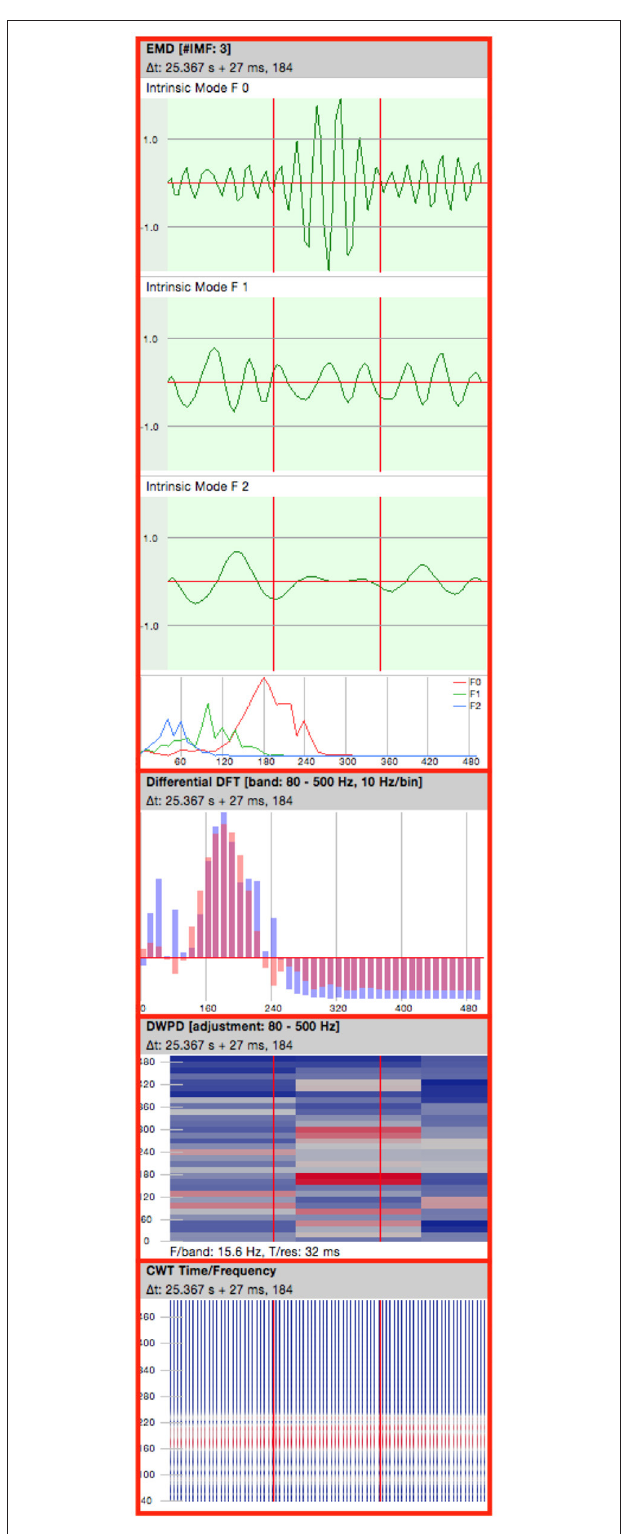
FIGURE 3 | Analysis pane. EMD, Empirical Mode Decomposition (4 consecutive oscillations are shown); DFT, Differential Fourier Transform; DWPD, Discrete Wavelet Packet Decomposition; CWT, Continuous Wavelet Transform.